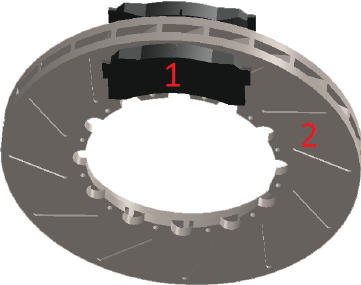
Figure 1: Disc brake friction pair: 1 - brake pads and 2 - correspond- ing brake disc